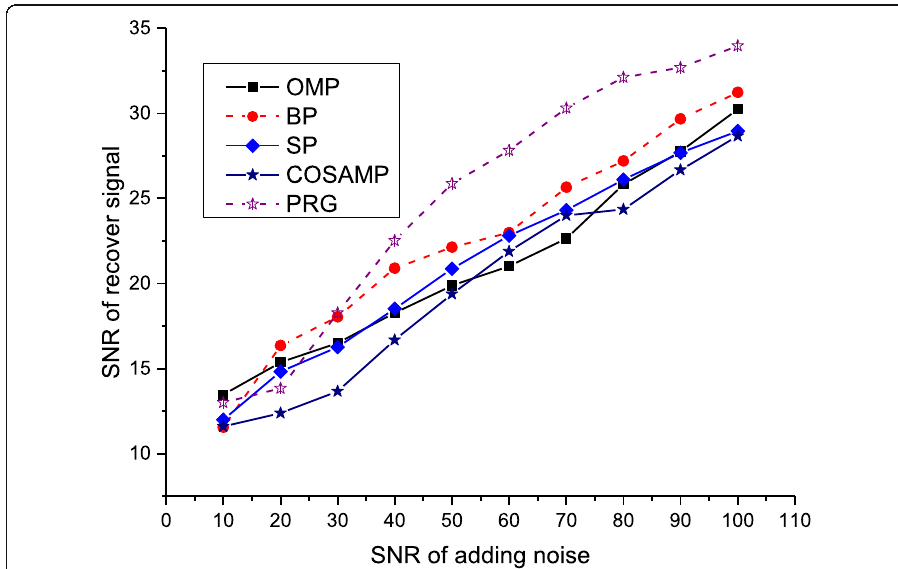
Fig. 5 Sensor signal reconstruction under Gaussian white noise. The SNR of the reconstructed wireless sensor signal by PRG, OMP, SP, BP, and COSAMP. The SNR of noise is 10, 20, 30, 40, 50, 60, 70, 80, 90, and 100,